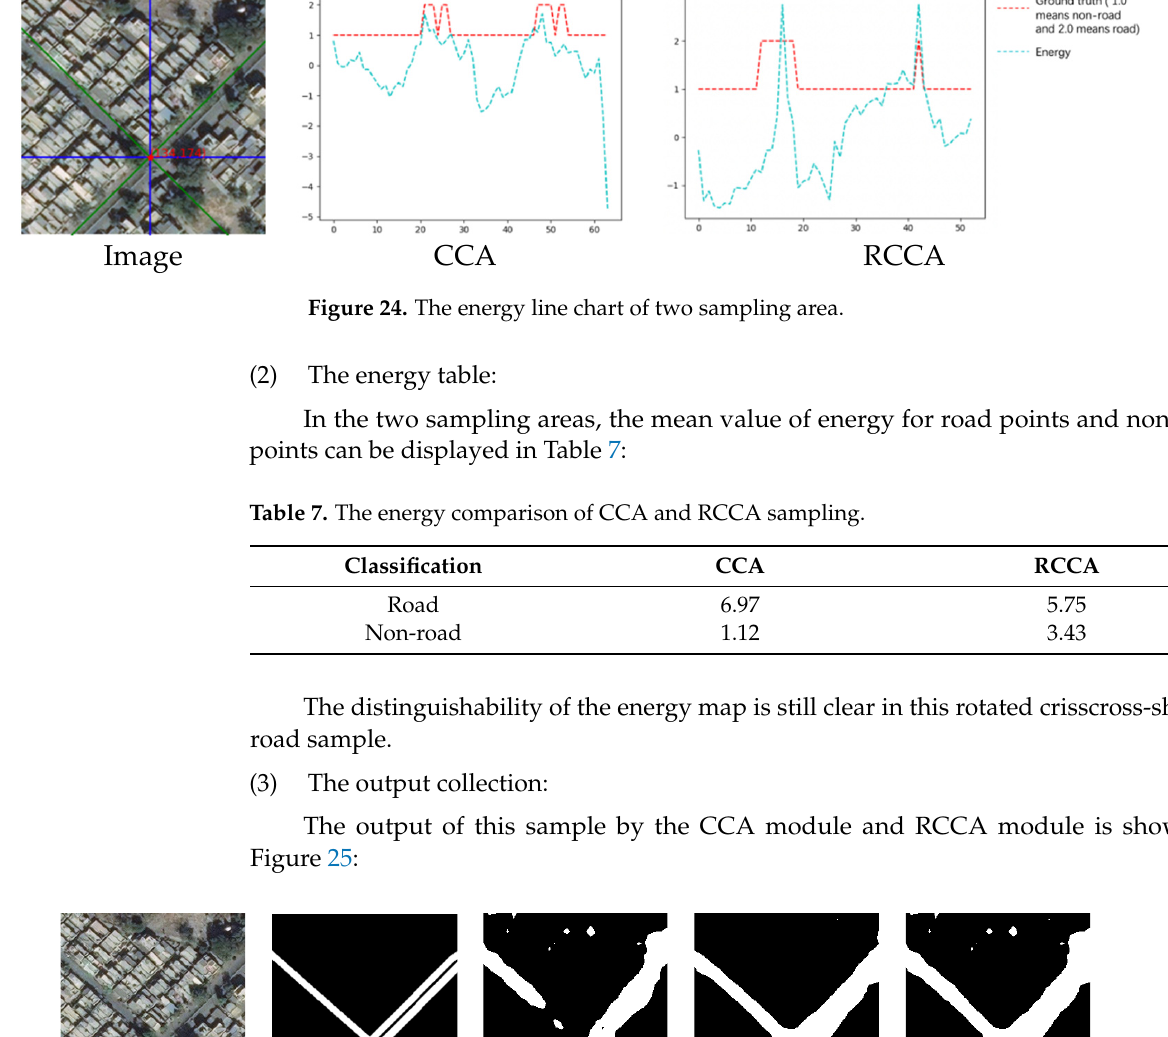
Figure 23. The image and its ground truth.